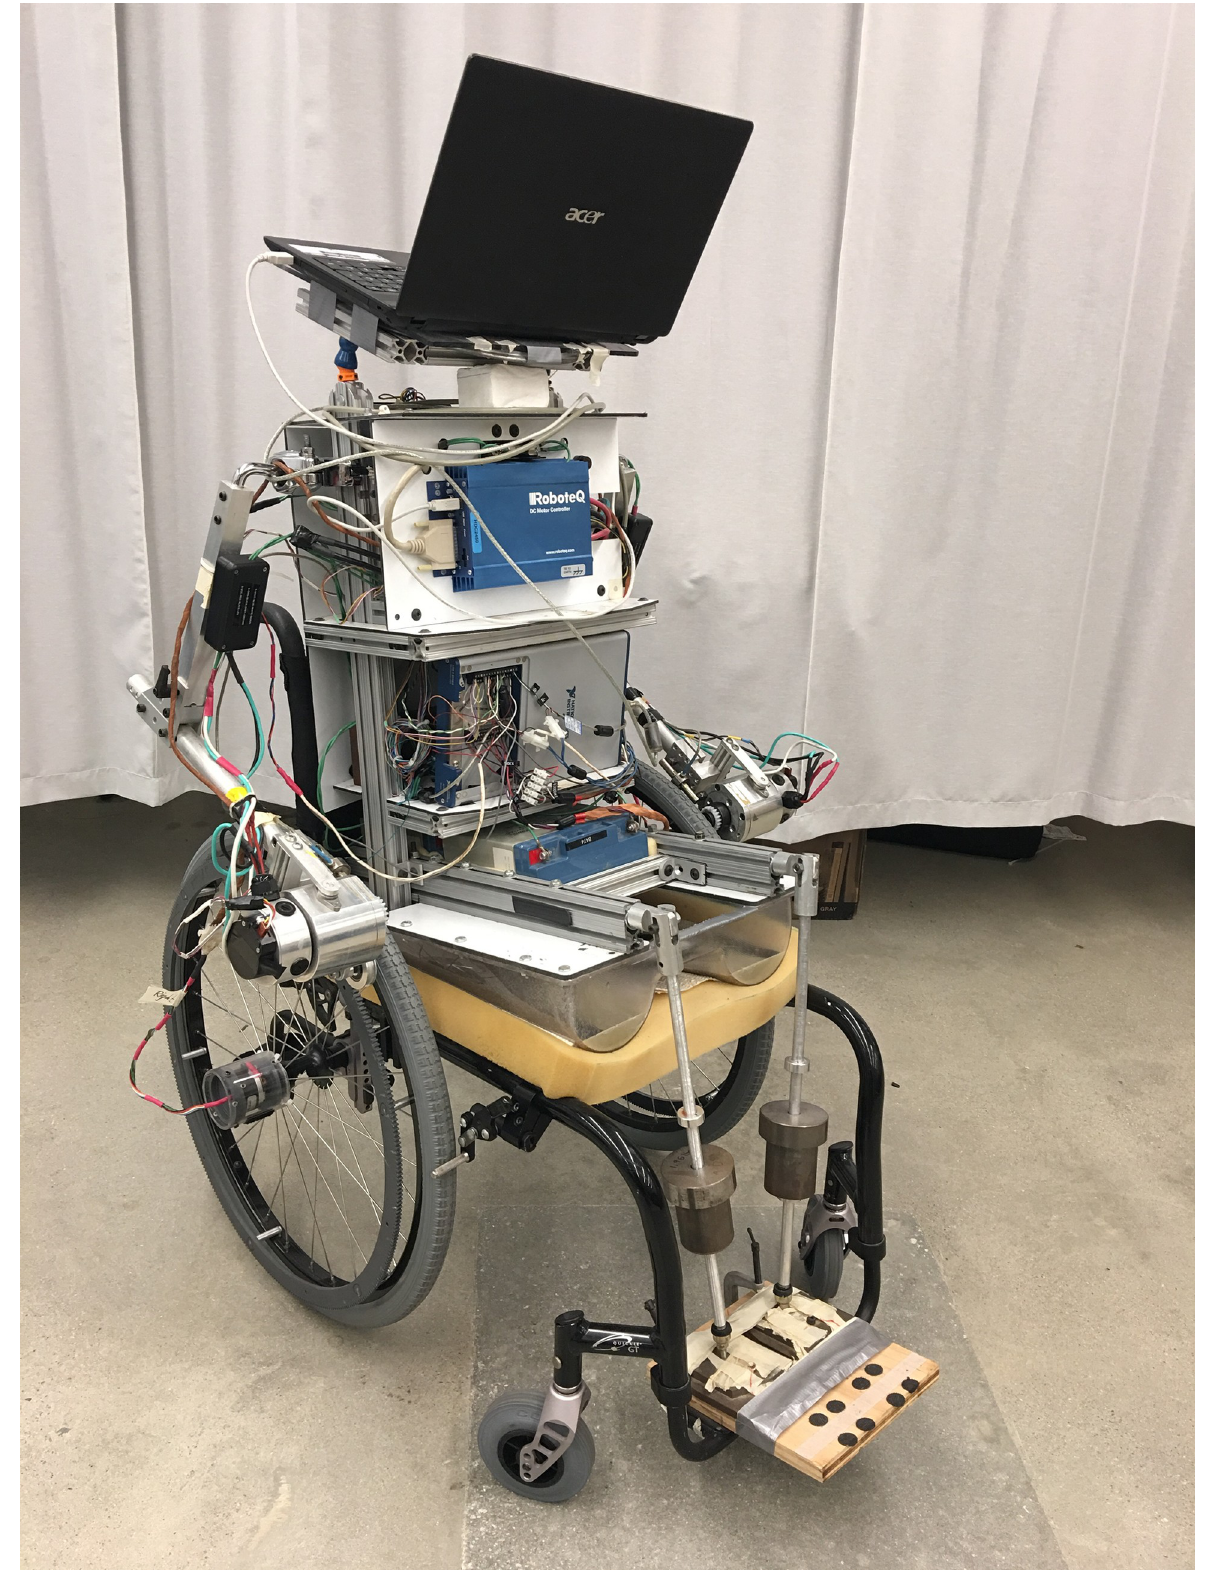
Fig 4. The AMPS. The Anatomical Model Propulsion System configured to an ultra-lightweight manual wheelchair. https://doi.org/10.1371/journal.pone.0234742.g004 PLOS ONE | https://doi.org/10.1371/journal.pone.0234742 June 18,